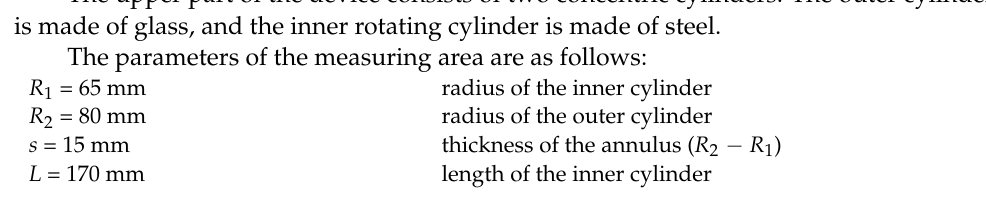
Figure 2. Flow between concentric cylinders during rotation of the inner cylinder, experiment and photos of the Couette and Taylor flow [15].